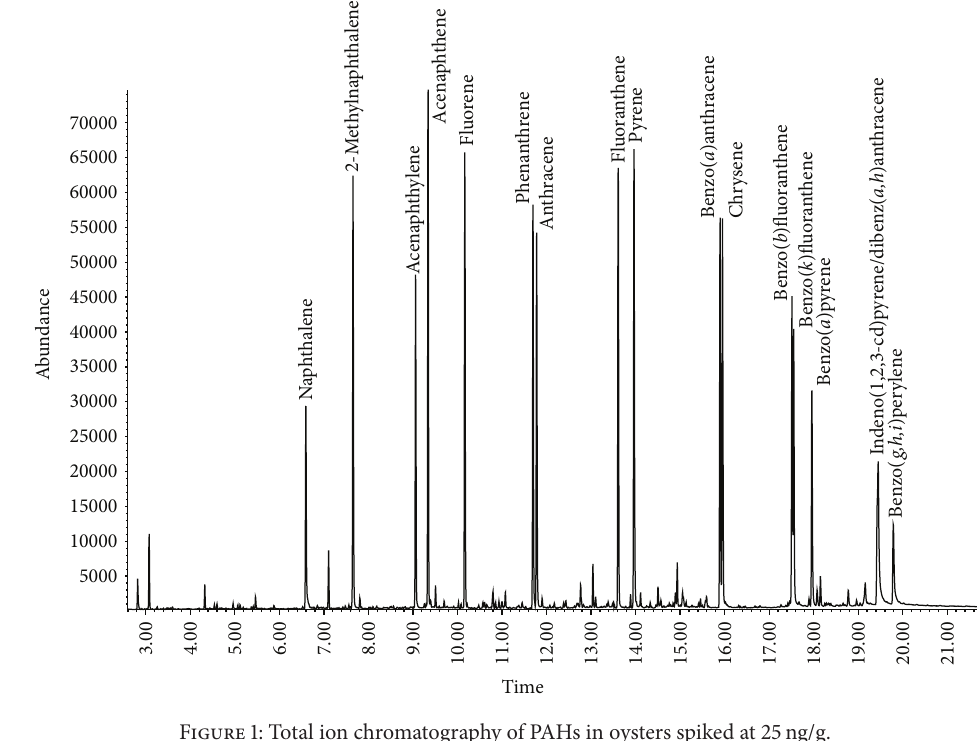
Figure 1: Total ion chromatography of PAHs in oysters spiked at 25 ng/g.